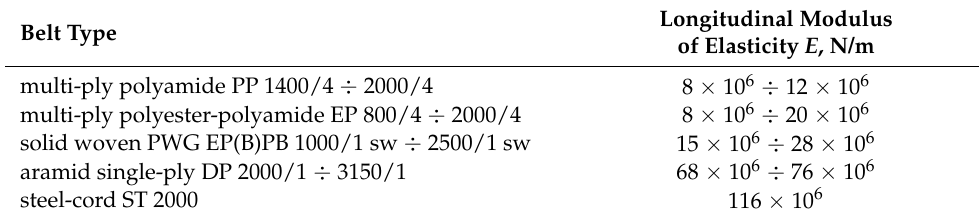
Table 1. Results of elastic modulus tests for conveyor